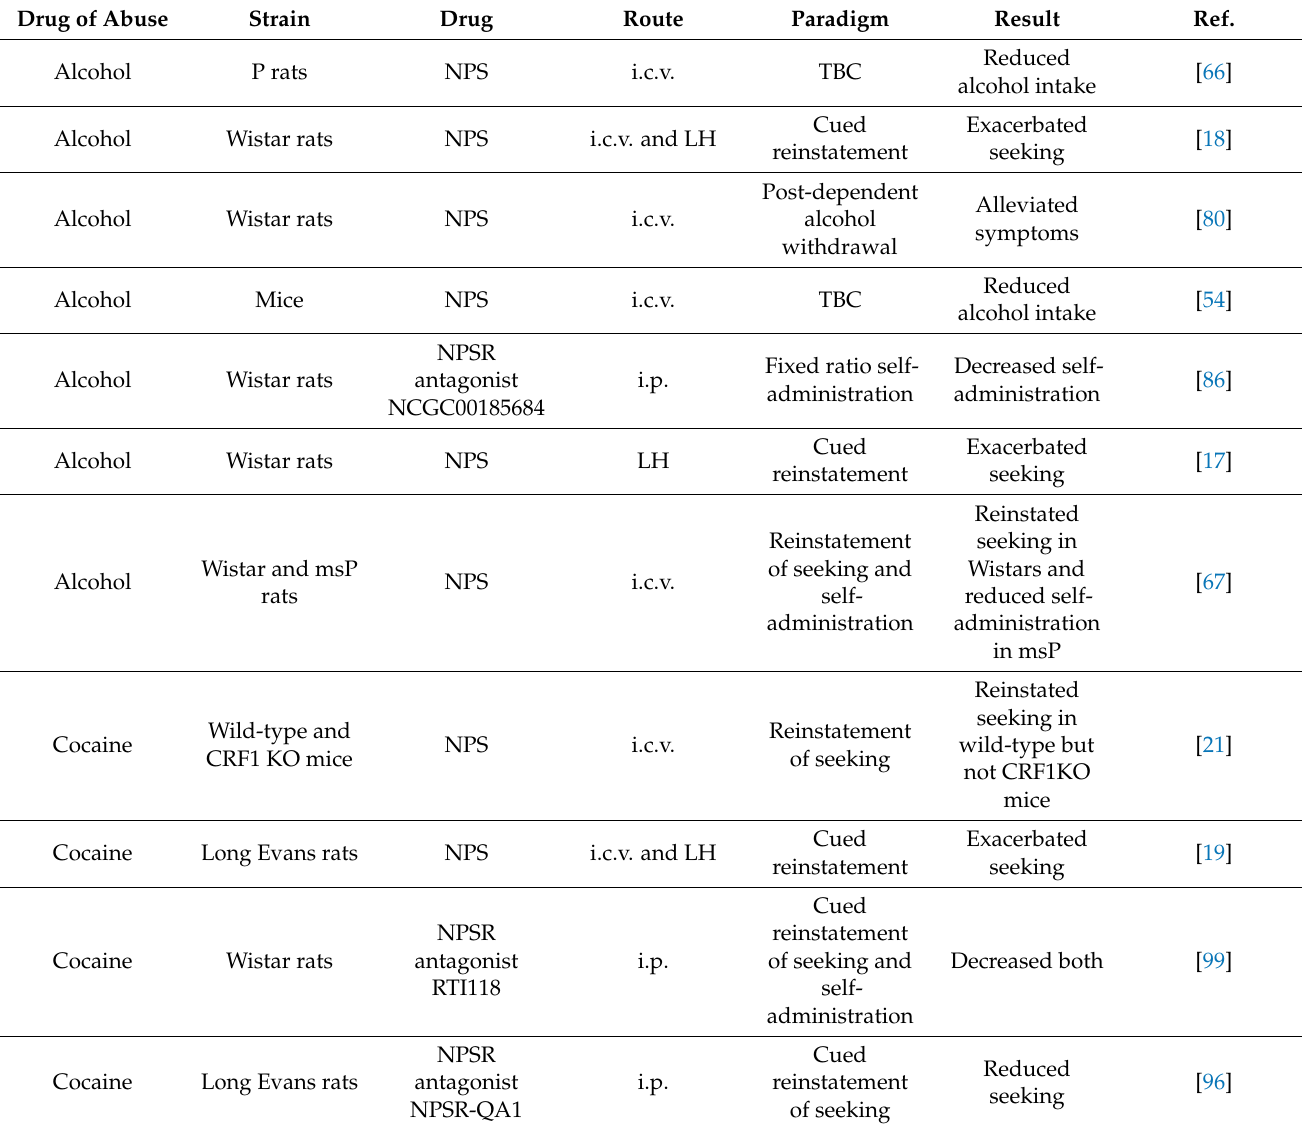
Table 2. Main preclinical findings on probing the NPS/NPSR system in alcohol and cocaine seeking.